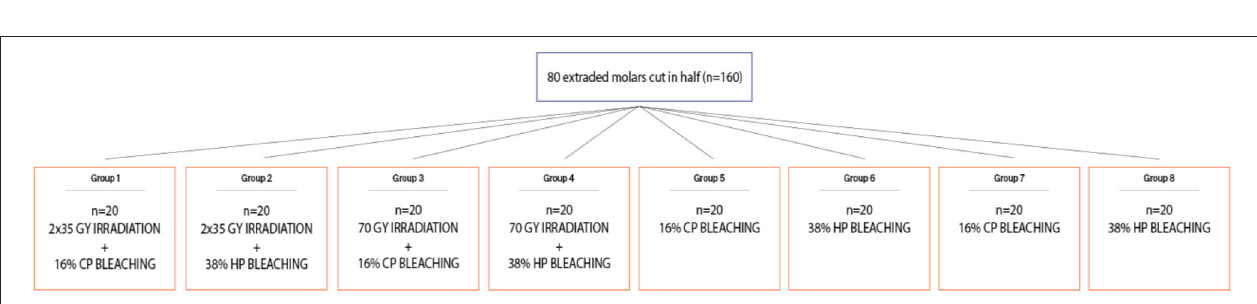
points on both enamel and dentin: surface, middle, and deep parts (at 50- µ m intervals). The average of all three Vickers hardness values obtained from enamel and dentin was recorded as the total value of enamel and dentin hardness (29,